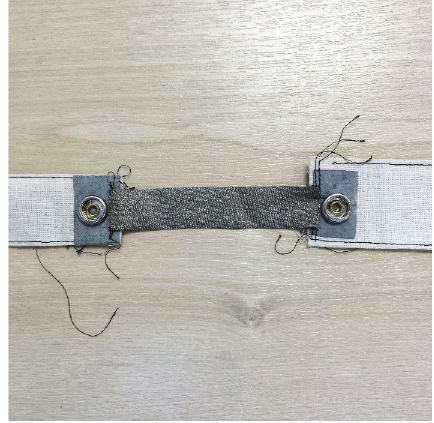
Figure 2. Sensor made with commercially produced conductive